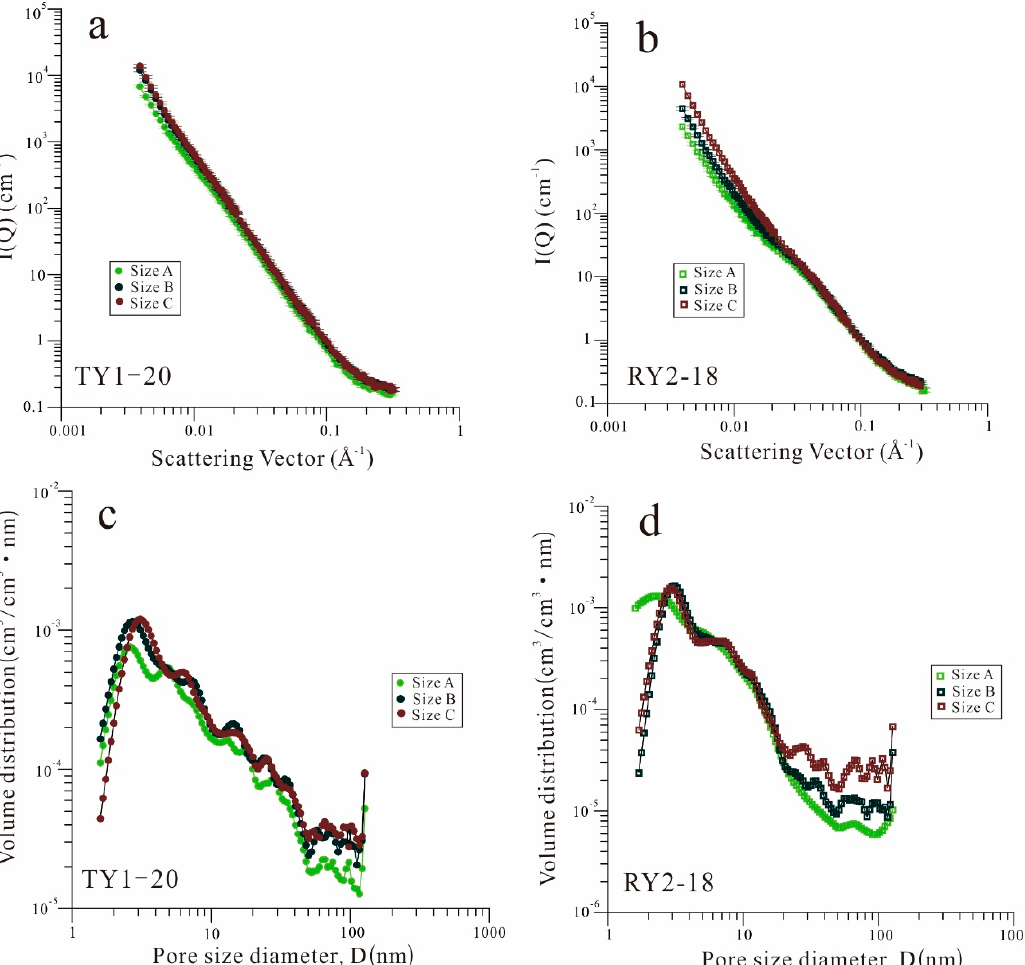
Figure 3. ( a , b ) Small-angle neutron scattering (SANS) profiles and ( c , d ) pore size distribution (PSD) for the TY1-20 and RY2-18 samples with three different particle sizes.